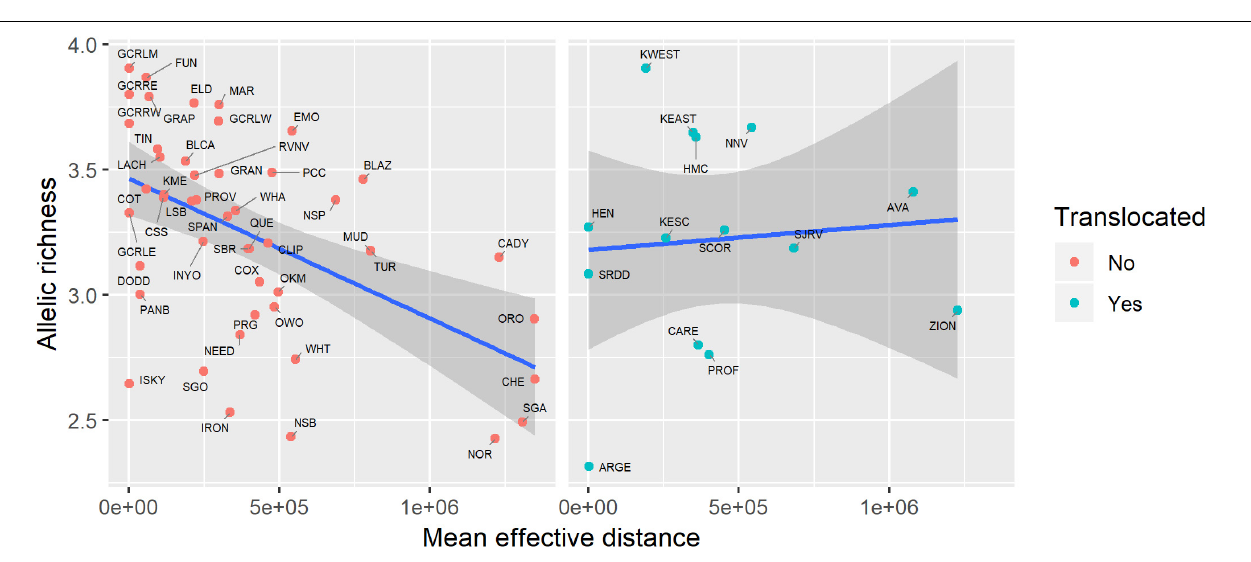
FIGURE 6 | Relationship between genetic diversity (measured as allelic richness) and geographic isolation (measured as mean effective distance to nearest three neighbors) for native and translocated desert bighorn sheep populations. Blue line and dark gray band show best fit line and 95 percent confidence interval, respectively, from linear regression model. See Table 1 for full population